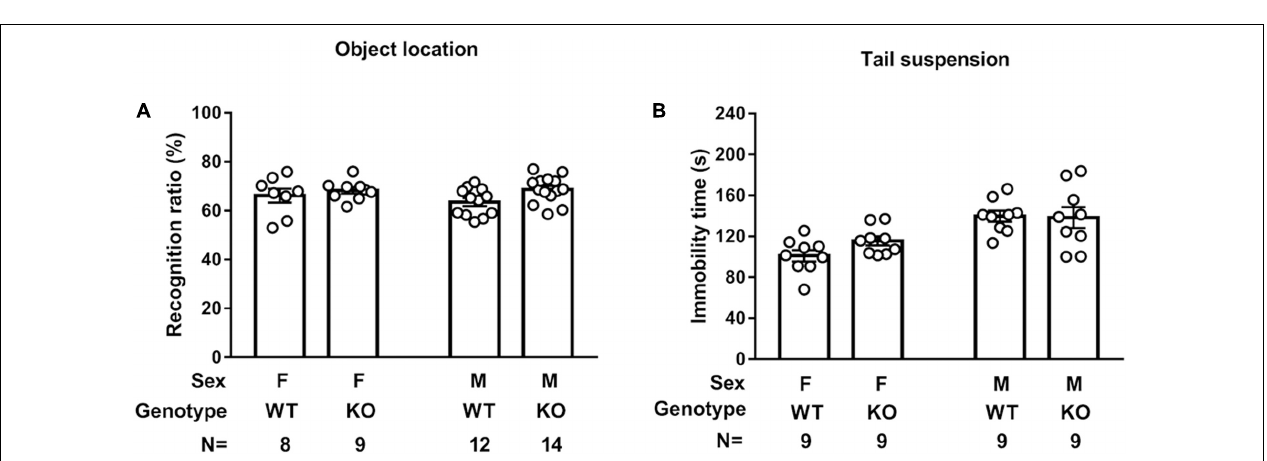
FIGURE 6 | Stress-provoked anxiety level and locomotion in open field free navigation task. (A) Navigation heating map representatives were listed. (B) SEPT14 KO mice exhibited less time spent navigating in the center as compared to their same-sex WT ones [ F (1,12) = 21.43, p = 0.0006]. Four groups of mice demonstrated comparable (C) traveling distance and (D) velocity in this navigation task. The bar and error bar represent group mean and SEM, respectively.